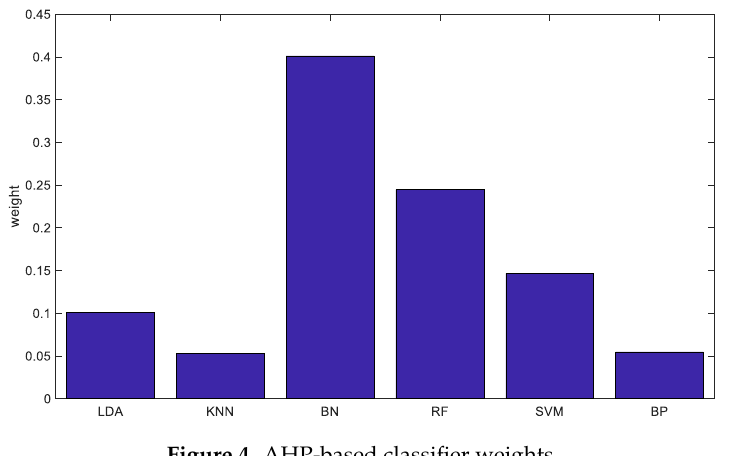
Figure 6. EW-TOPSIS-based classifier weights